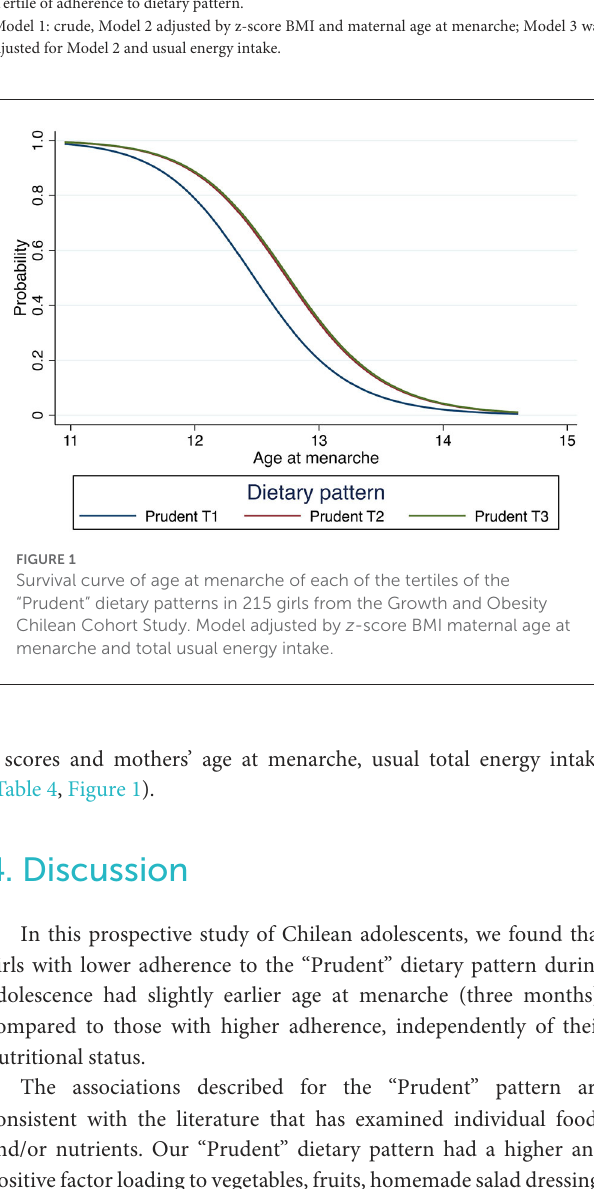
z scores and mothers’ age at menarche, usual total energy intake (Table 4, Figure